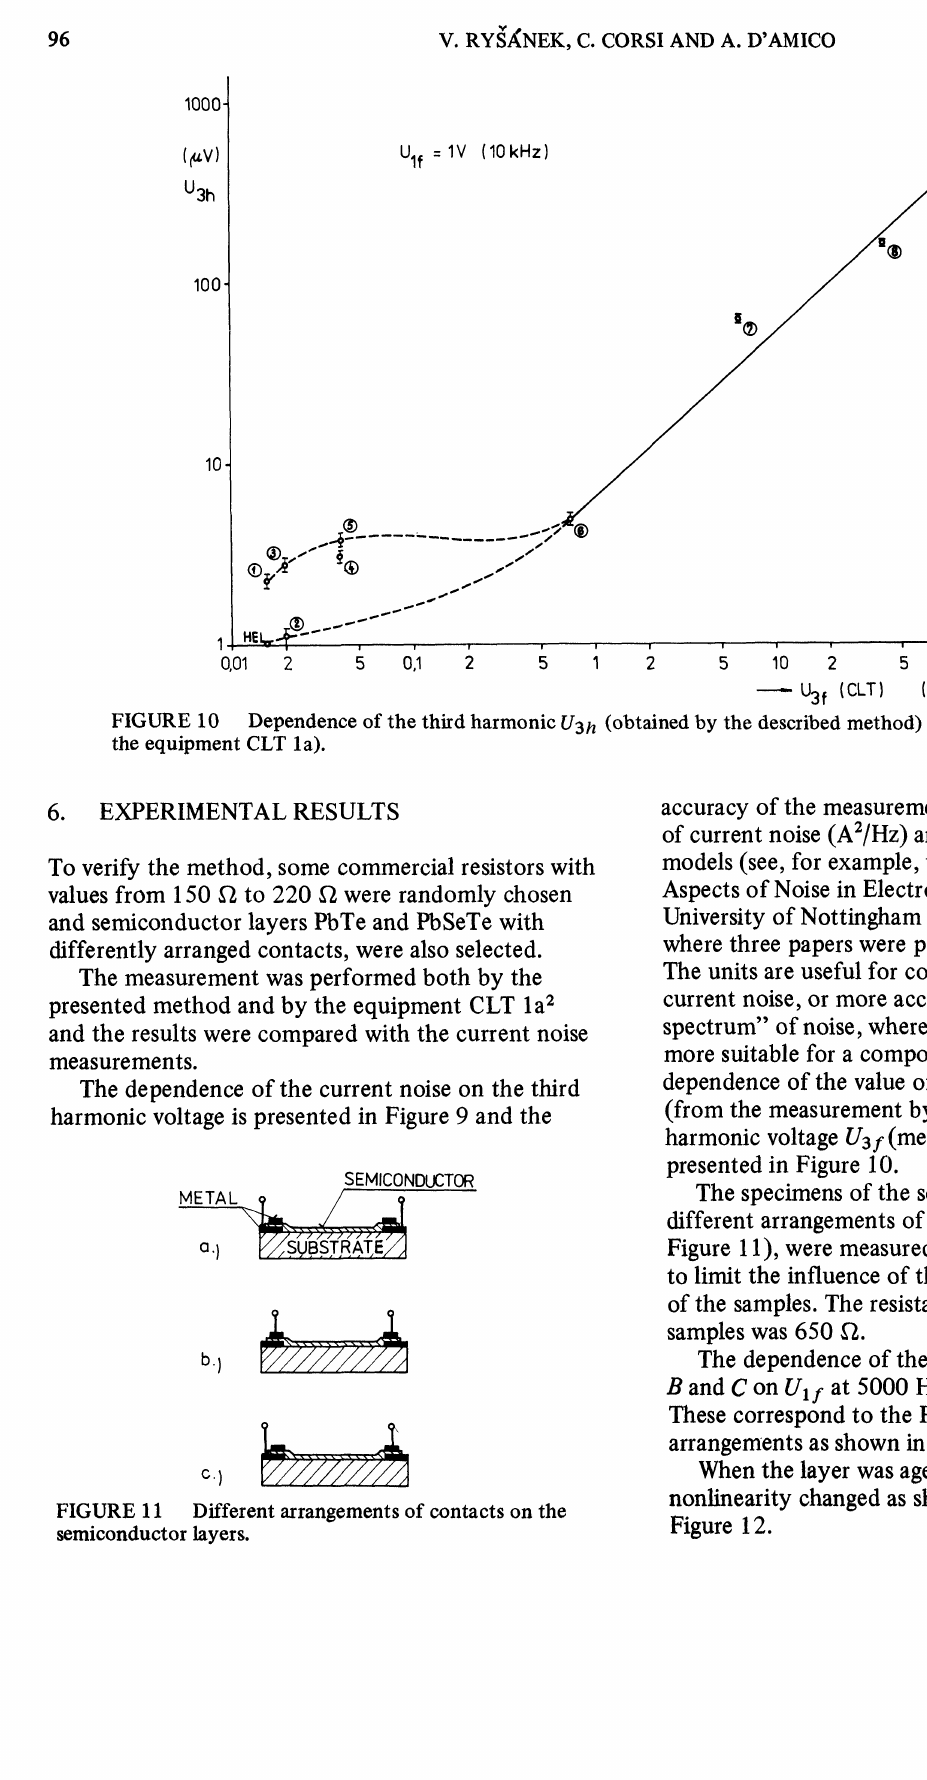
FIGURE 11 Different arrangements of contacts on the semiconductor